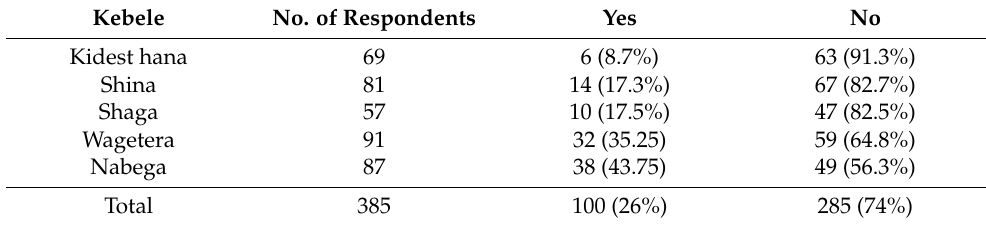
Table 7. Traditionally produced goods from wetland resources.